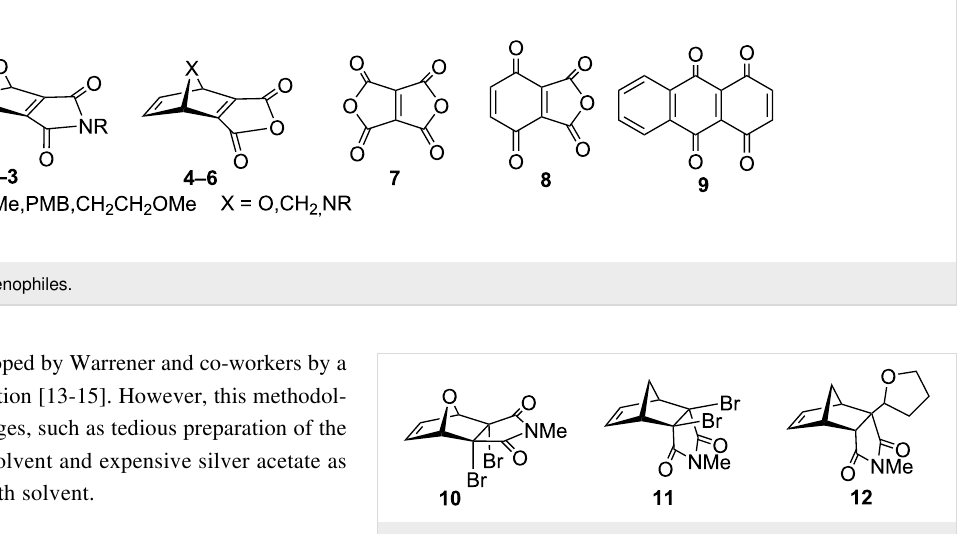
Figure 2: Dibromide substrates and product 12